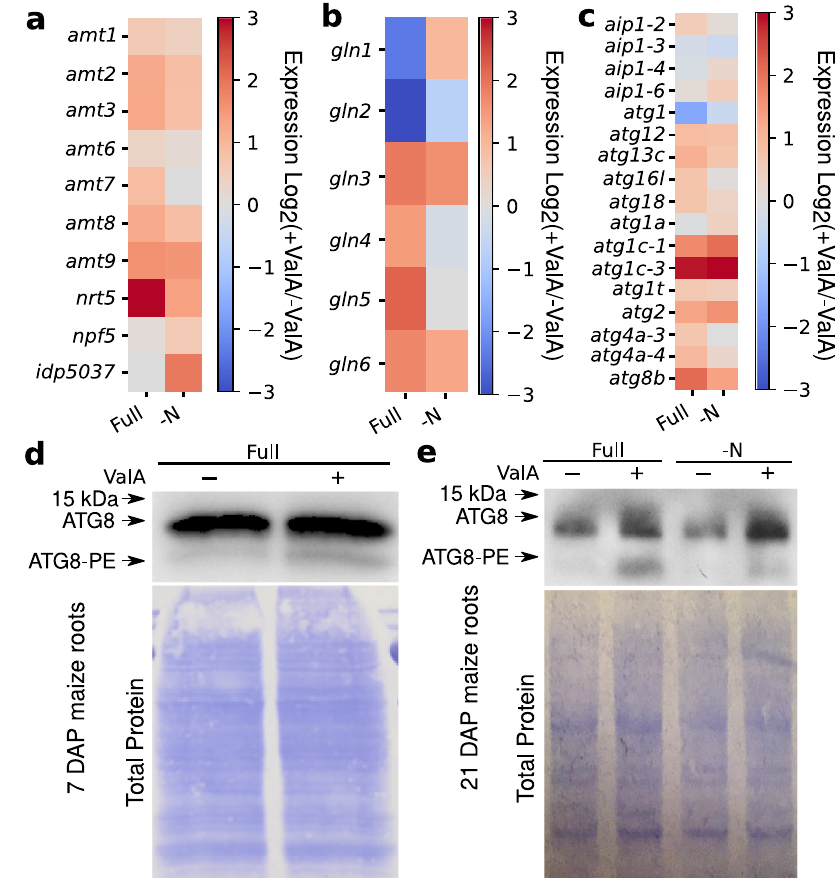
Fig. 5 | Evidence for increased autophagy in maize seedlings treated with validamycin A. a Change in the expression of genes encoding ammonium ( amt1 , amt2 , amt3 , amt6 , amt7 , amt8 , amt9 ) and nitrate ( nrt5 , npf5 , idp5037 ) transporters in response to ValA treatment. b Change in the expression of genes encoding glutamine synthetase root isozymes ( gln1 , gln2 , gln3 , gln4 , gln5 , gln6 ) in response to ValA treatment. c Change in the expression of genes related to autophagy in response to ValA treatment. d Abundance of free ATG8 (upper band)and ATG8-PE